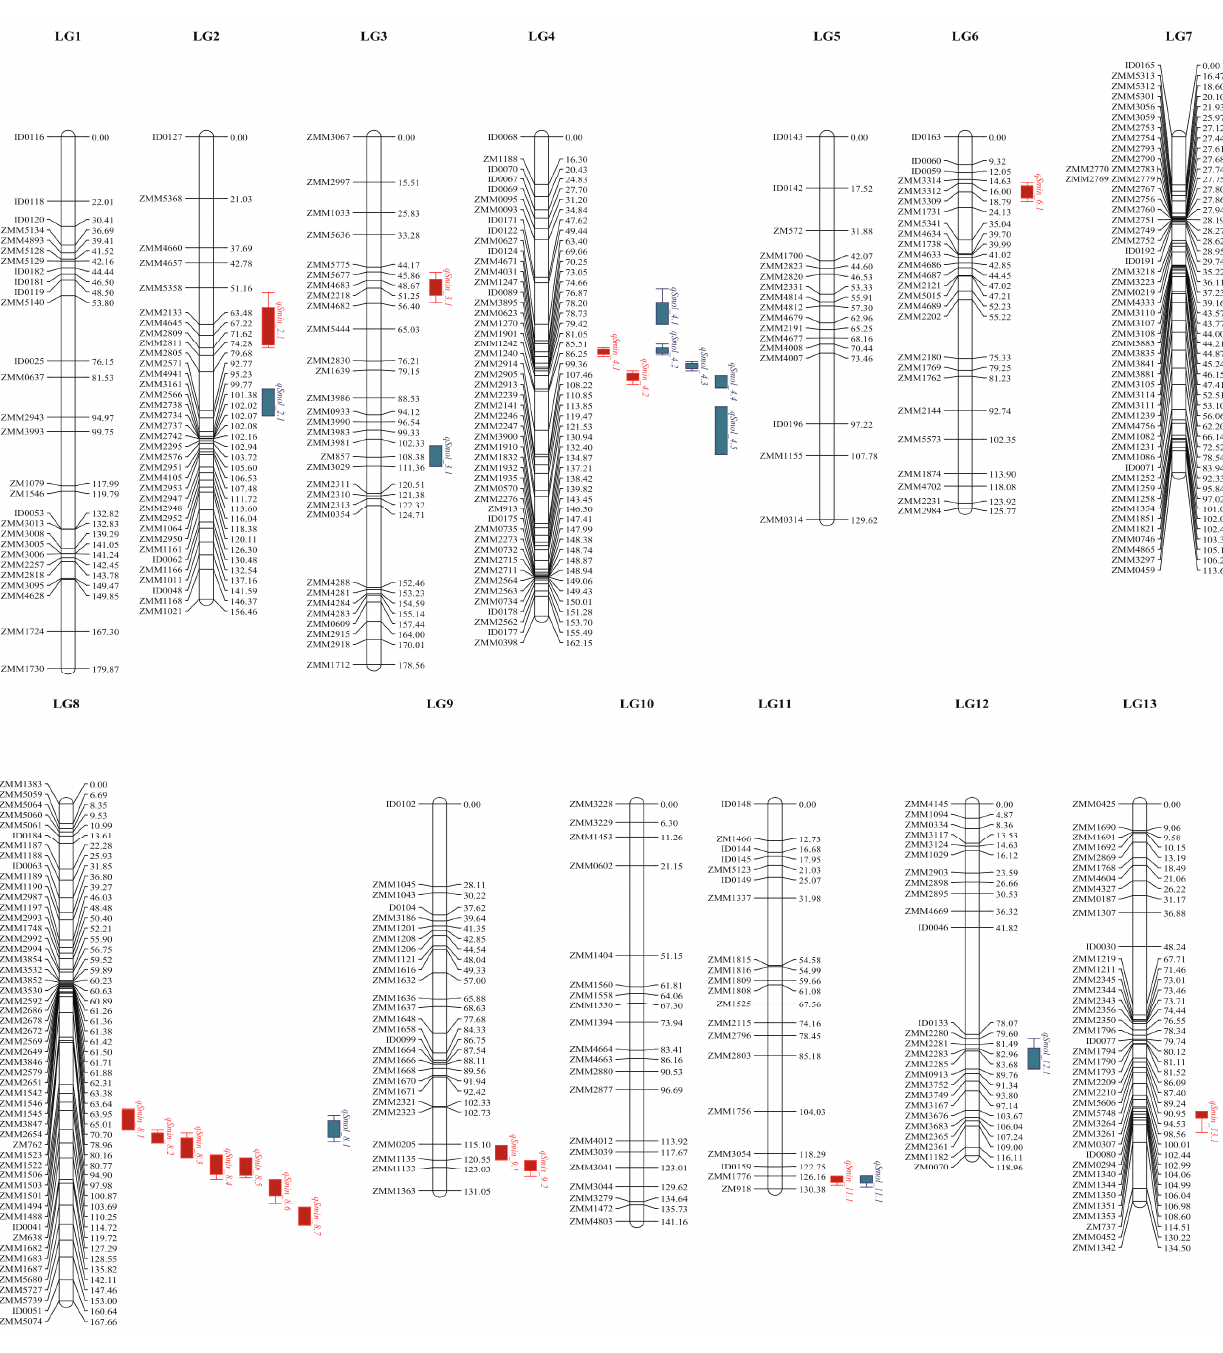
Figure 2. QTLs for sesamin and sesamolin positions on linkage groups of Zhongzhi No.13 × ZZM2748. Note: the red and blue bars stand for QTLs associated with sesamin and sesamolin, respectively.